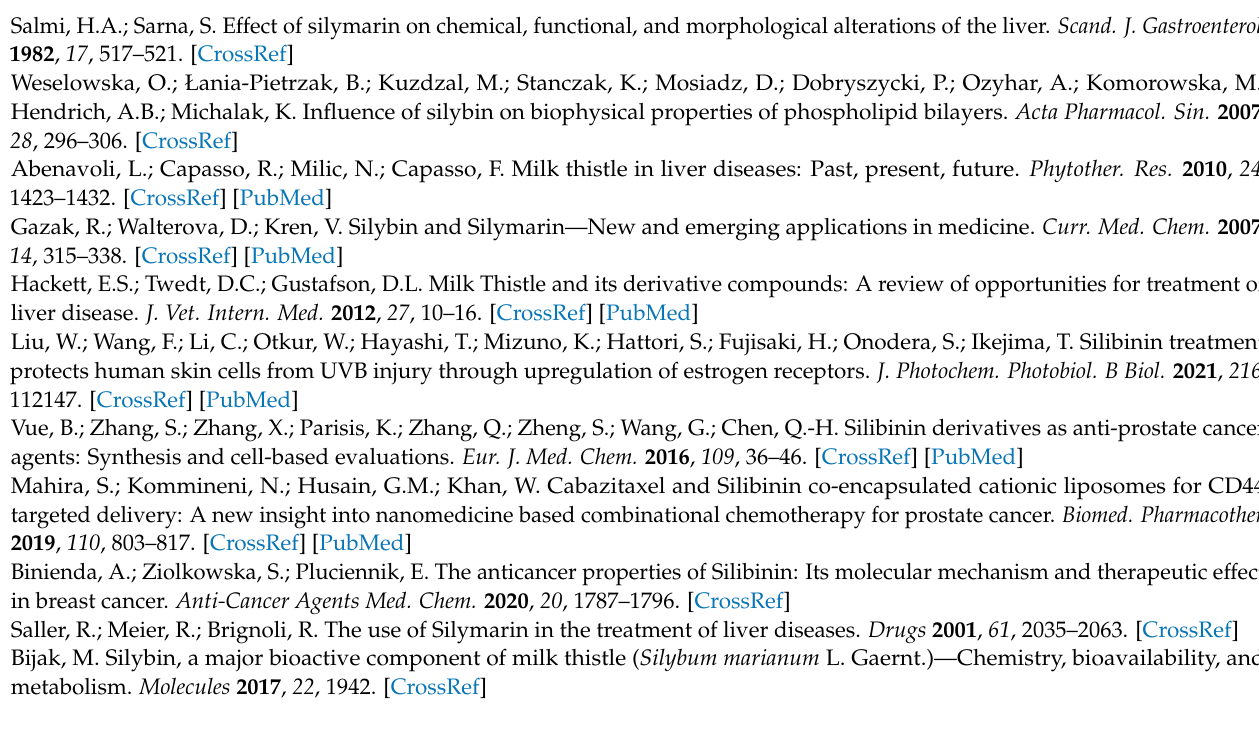
390/pharmaceutics13122025/s1. Figure S1: GPC eluograms of crude (a) and purified (b) OEC-VI. Figure S2: (a)Representative 1 H NMR spectrum of OEC-VII in CDCl 3 for determination of the average DP of the PEG chains and number average molar mass (M n ).-; (b) DOSY spectrum of OEC-IV in CDCl 3 (10 mg/mL); (c) DOSY spectrum of OEC-VII (10 mg/mL in D 2 O) showing the co-existence of two populations of particles—unimers and macromolecular aggregates. Figure S3: (a) Debye plot for OEC-VII in water at 25 ◦ C in the concentration range below the CMC. Measurements were made at an angle of 90 ◦ ; (b) Zimm plot for OEC-VII in water at 25 ◦ C in the concentration range above the CMC. Figure S4: Particle size distribution from DLS of OEC-VII in water at 25 ◦ C in the transition concentration range. Measurements were made at an angle of 90 ◦ and c = 6.2 mg/mL. Table S1: SLS characterization parameters of selected samples in water at 25 ◦ C in the concentration ranges below or above the